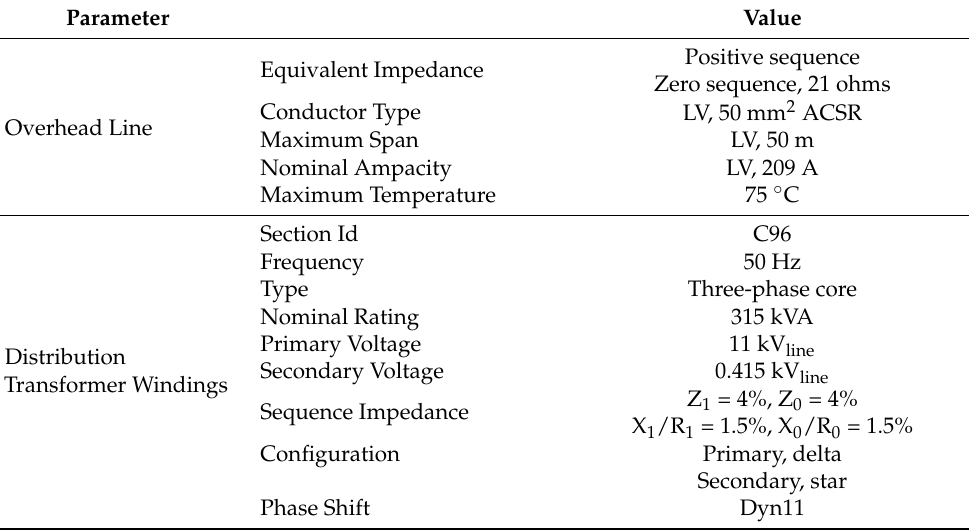
Table 2. Data on overhead line showing conductor type and nominal data on windings of distribution transformer for the LV